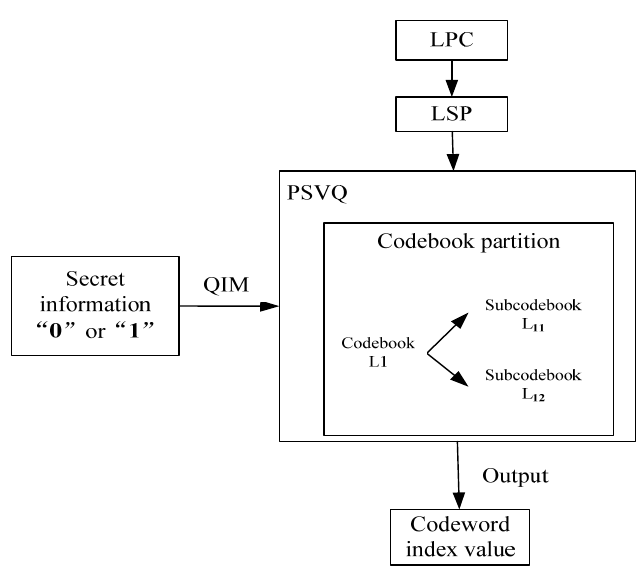
Figure 1. Binary codebook flow chart.